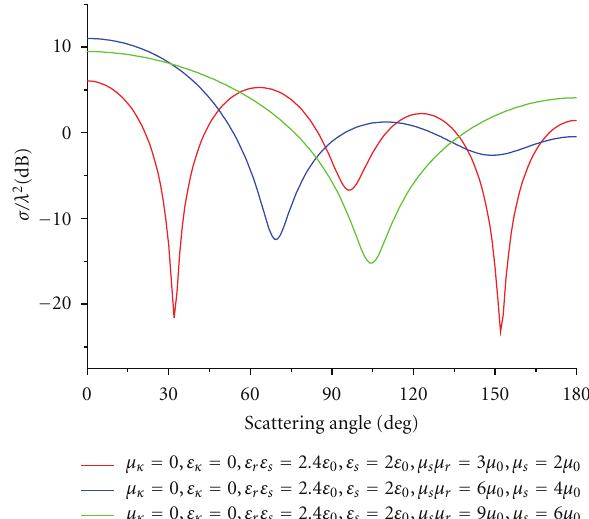
Figure 2: Normalized Radar cross-section (RCS) values versus the scattering angle. Di ff erent gyromagnetic influence is considered. Here, k 0 r = 0 . 75 π